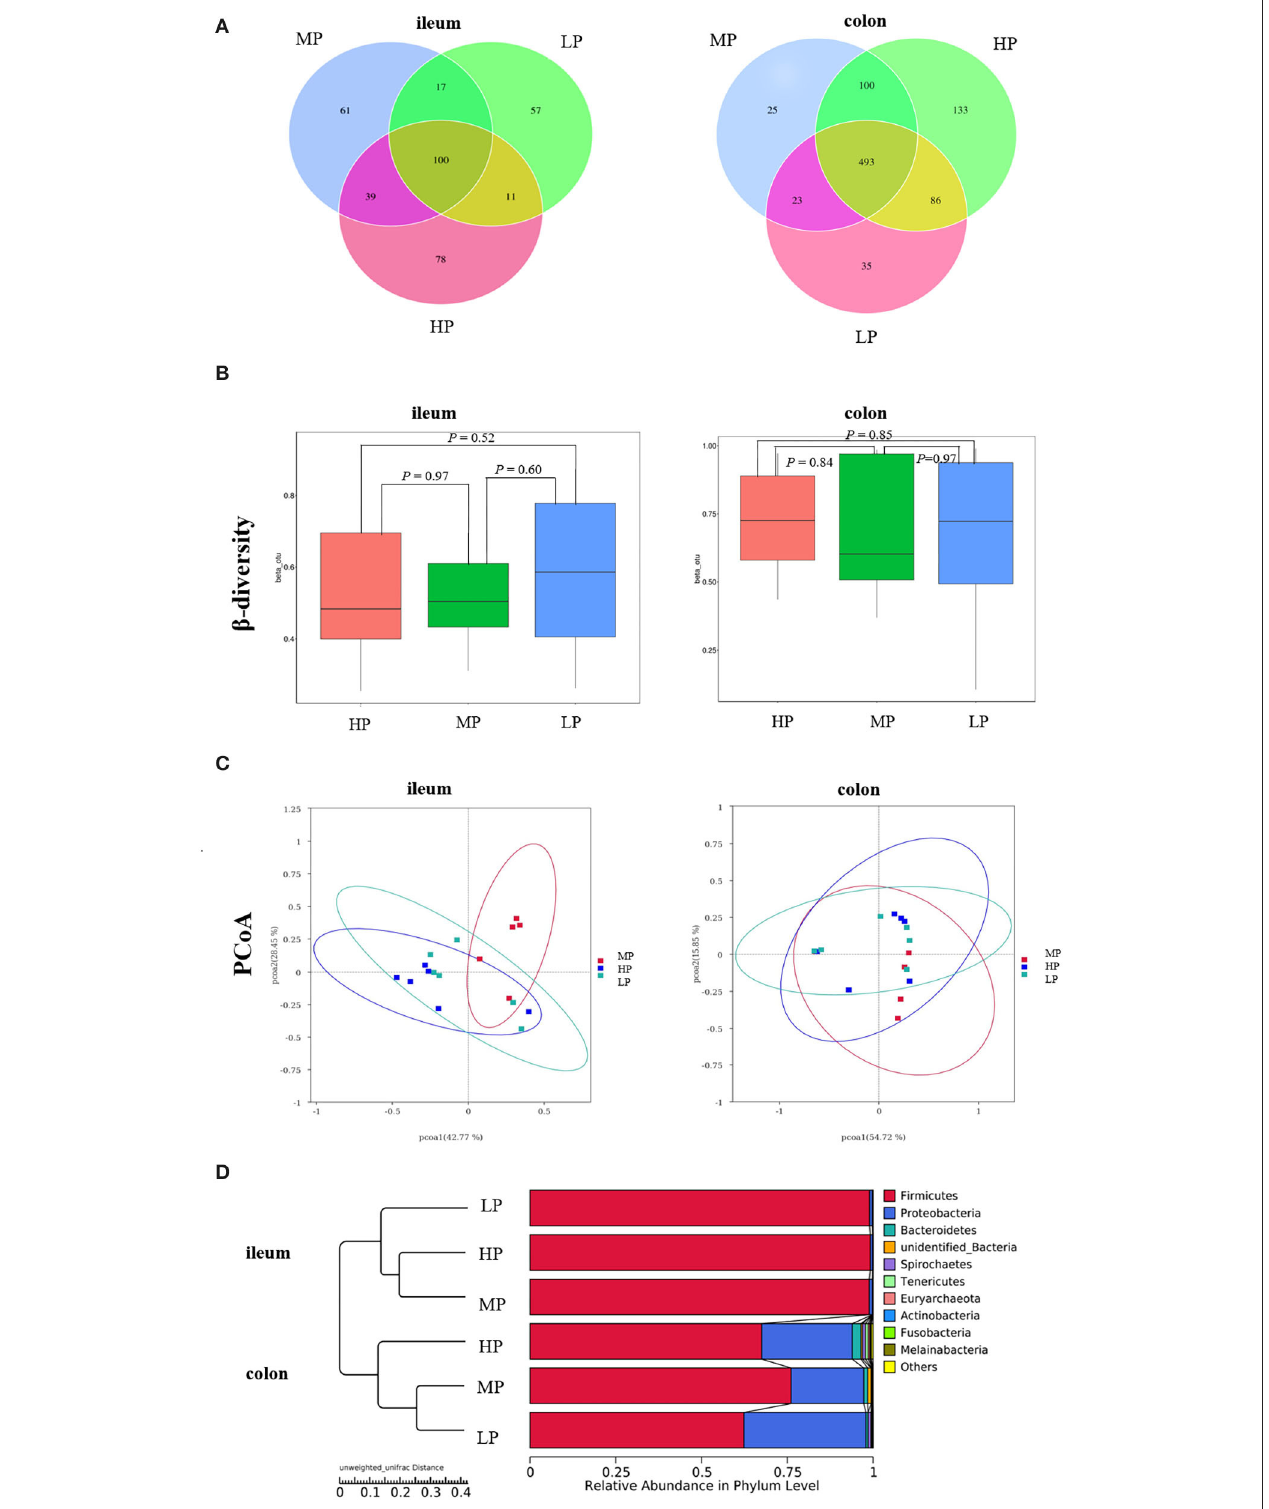
FIGURE 4 | The Venn diagram and UPGMA cluster tree of gut microbiota in finishing pigs. (A) The Venn diagram. (B) β -diversity index. (C) PCoA plot. (D) UPGMA clustering was conducted based on unweighted unifrac distance. HP, high protein (16% crude protein); MP, medium protein (12% crude protein); LP, low protein (10% crude